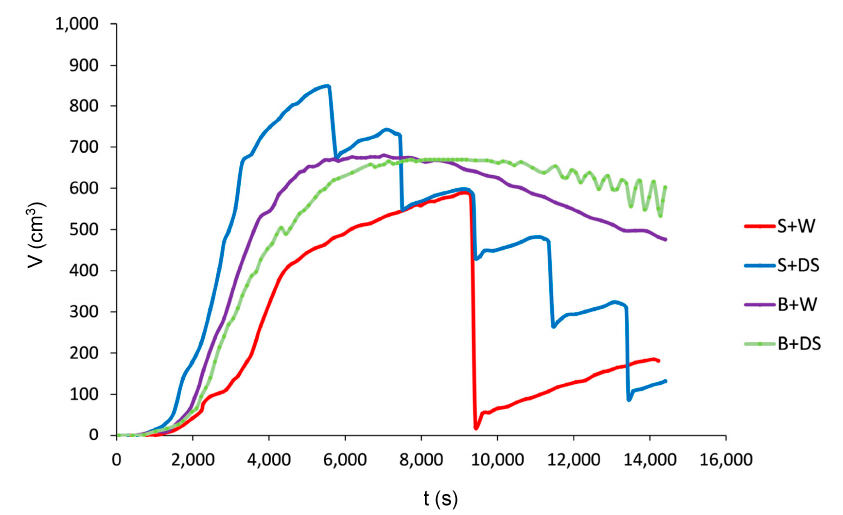
Figure 5. Volume of liquid accumulated in the tray.